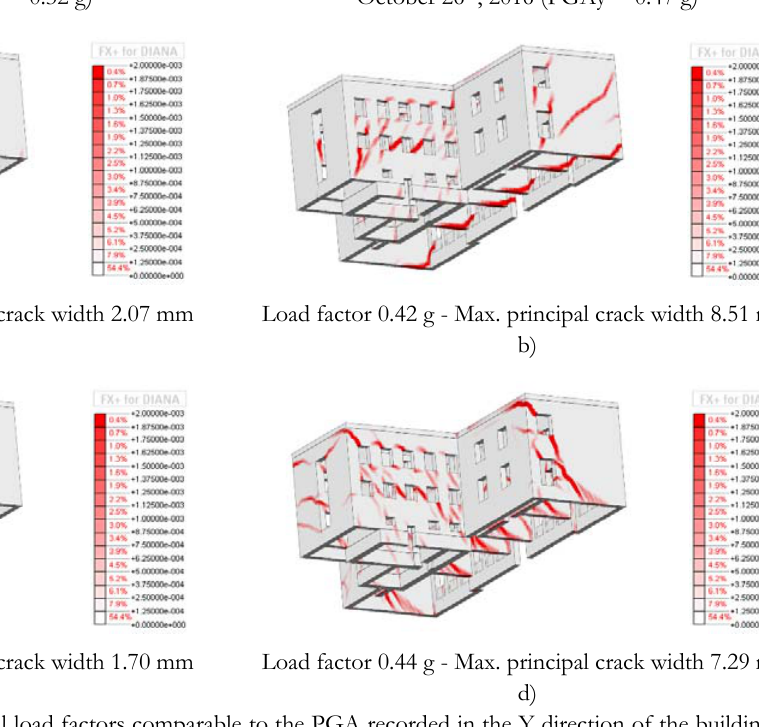
Figure 17: Principal crack width for horizontal load factors comparable to the PGA recorded in the Y direction of the building in the seismic events of August 24 th , 2016 (left) and October 26 th , 2016 (right): a)-b) +Y direction, c)-d) -Y